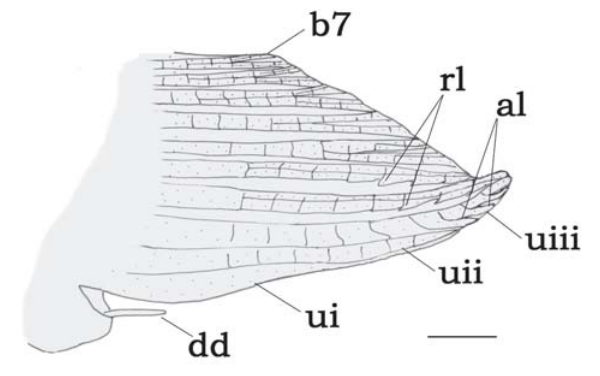
Fig. 38. Male modified anal fin of Tatia nigra , MNRJ 32024, 97.0 mm SL. Left side lateral view. Abbreviations: al , antrorsely curved distal segment; b7 , branched seventh ray; dd , defer- ent duct; rl , retrorsely curved distal segment ; ui , unbranched first ray; uii , unbranched second ray; uiii , unbranched third ray. Scale bar = 1.0 mm.